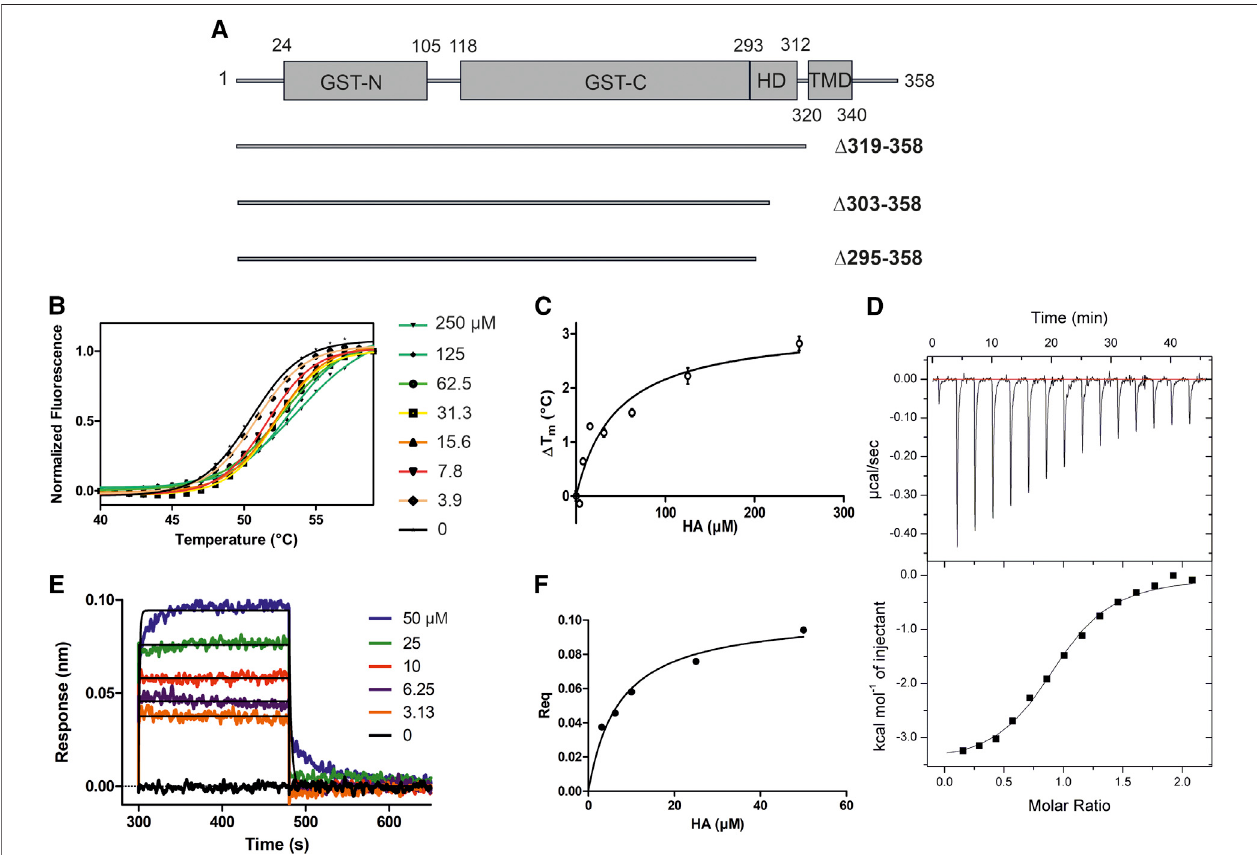
FIGURE 1 | HA binding stabilizes GDAP1 Δ 319-358. (A) Schematic of the full-length GDAP1 and three different deletion constructs used in this study. (B) Thermal unfolding data. (C) T m shifts of GDAP1 Δ 319-358 upon HA titration. (D) ITC binding curve of HA binding to GDAP1 Δ 319-358. (E) BLI response of streptavidin-coated sensors derivatized with biotinylated GDAP1 Δ 319-358 and exposed to increasing concentrations of HA. (F) Steady-state analysis of the BLI response vs. HA concentration.